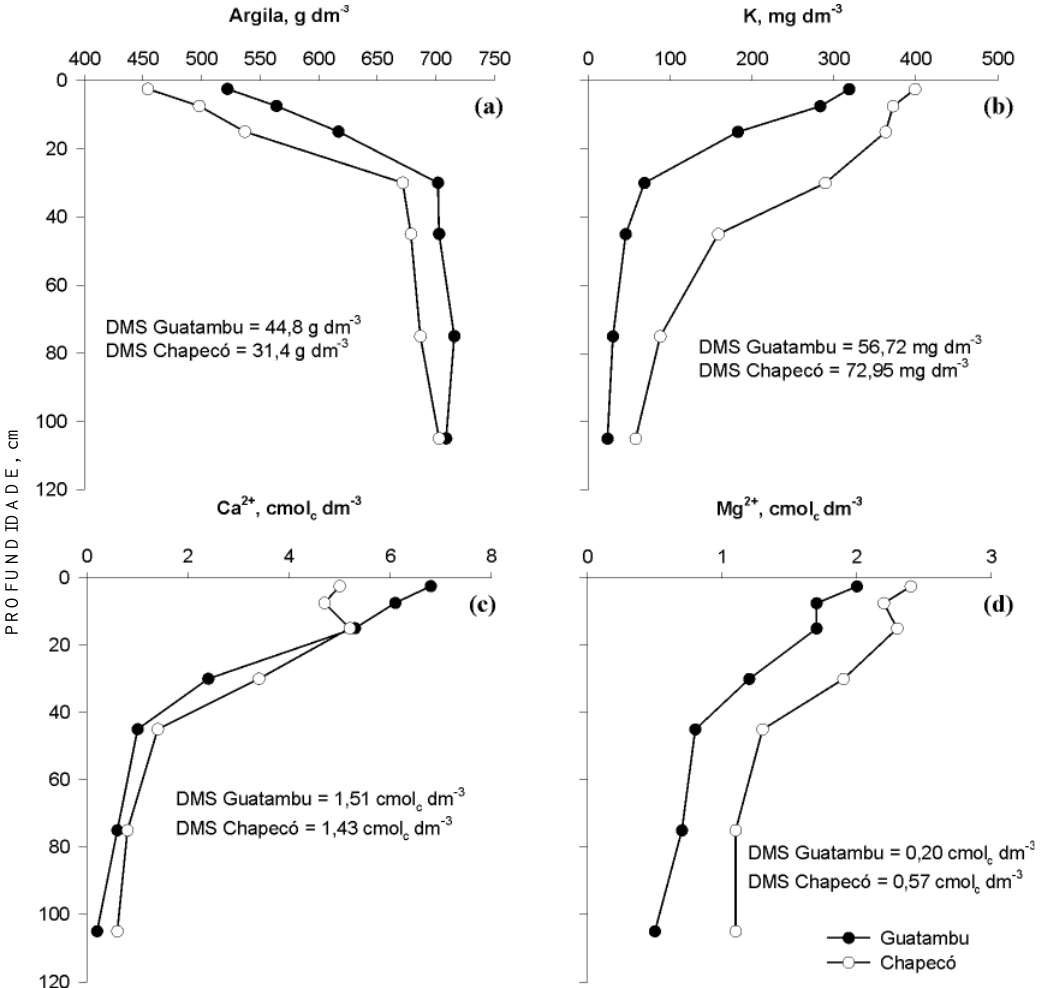
Figura 2. Teores de argila (a), potássio (b), cálcio (c) e magnésio (d) no perfil do solo, em diferentes profundidades, considerando a aplicação de esterco de suínos por três anos em Guatambu e quatro anos em Chapecó. DMS = diferença mínima significativa entre profundidades para o teste de Tukey a 5